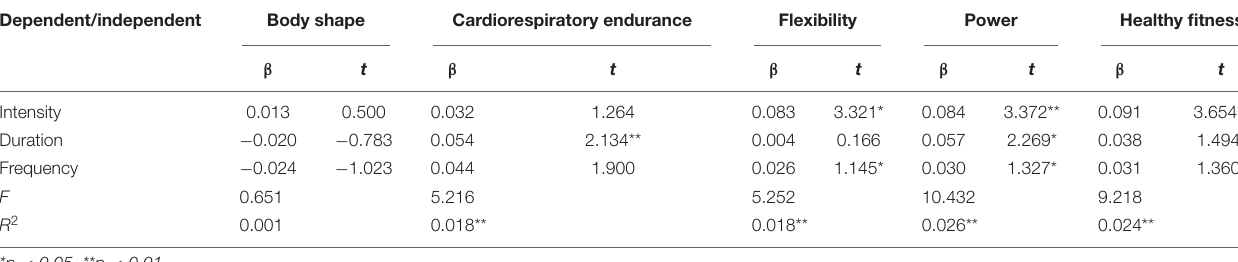
TABLE 4 | Regression analysis between exercise behavior and physical fitness ( N = 1,923). Dependent/independent Body shape